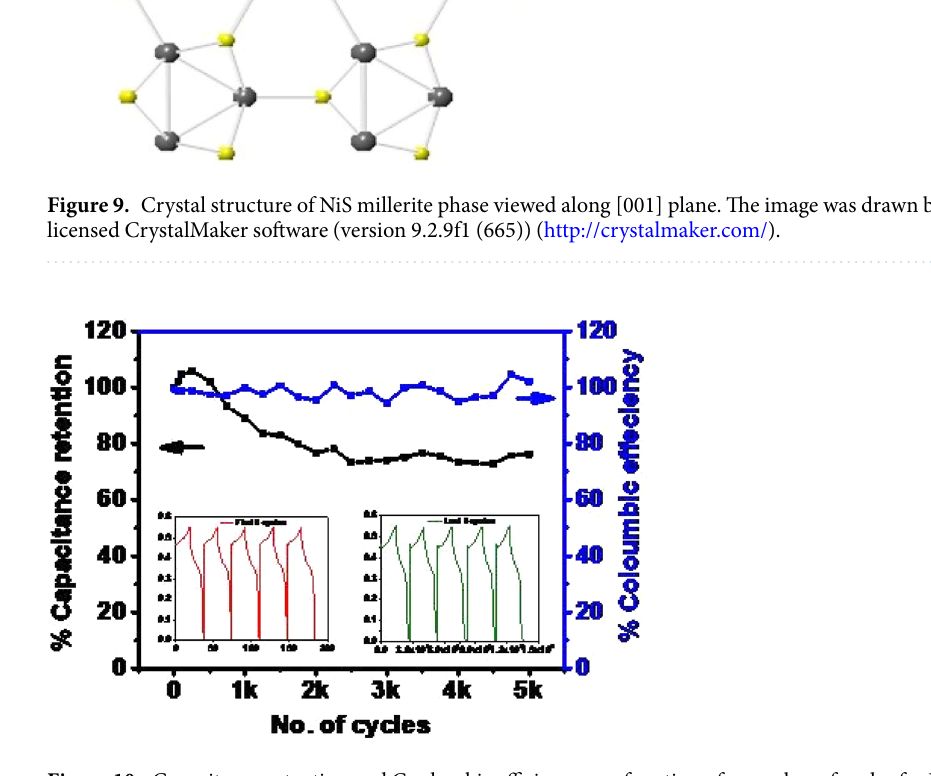
The electrocatalytic performance of NiS samples synthesized from complexes (1) and (2) as OER and HER electrocatalysts was investigated using linear sweep voltammetry (LSV). The polarization curves in OER for all samples are shown in Fig. 11a. The overpotentials for the samples were found to be 139 mV for NISE-3, 147 mV for NISE-2, 161 mV for NISE-1, and 380 mV for NISO at a current density of 10 mA/cm 2 . Xiao et al . have synthe- sized NiS/Ni 2 P in carbon cloth, which provides an overpotential of 265 mV for the OER to reach a current density of 20 mA/cm 2 30 . According to Chen et al ., NiS grown on stainless steel exhibits an overpotential of 297 mV at 11 mA/cm 2 , with a Tafel slope of 47 mV/dec 78 . As shown in our work, NISE-3 displayed the lowest overpotential (139 mV) compared to the other studied samples and other reports in the literature, ensuring best energy gen- eration applications. The catalytic performance was also much higher as compared to the other commonly used binary/ternary oxide-based and/or Ni-based state of the art OER catalysts. A detailed comparison of the best OER activity achieved in this work with some previously reported Ni-based electrocatalysts is given in Table S4, ESI. The OER activity of the NiS samples was also compared with that of RuO 2 and Pt electrocatalysts, in which NISE-3 demonstrated superior performance (NISE-3 > NISE-2 > NISE − 1 > RuO 2 > NISO > Pt (Figure S9, ESI). The Tafel slope indicates the reaction kinetics for the different catalysts. For NISE-3, which presents the lowest overpotential, the Tafel slope is only 32 mV/dec, showing a fast and efficient process (Fig. 11c). The polarization curves for HER are provided in Fig. 11b, indicating best result for NISE-3. For NiS/Ni 3 S 4 synthesized by Qin et al ., the HER activity reached a low overpotential of 221 mV at 10 mA/cm 2 , which is comparable with our results 79 , whereas, it is much superior as compared to NiS (474 mV at 10 mA/cm 2 ), NiS 2 (454 mV at 10 mA/cm 2 ), Ni 3 S 2 phase (335 mV at 10 mA/cm 2 ) and Ni 3 S 2 -CNTs composites (480 mV at 10 mA/cm 2 ) 25,80 . A detailed comparison is given in Table S5, ESI. The reaction kinetics for all samples in HER is shown in Fig. 11d. Generally, the millerite, β -NiS phase has shown comparatively, much higher catalytic efficiency as compared to the hexagonal α -NiS